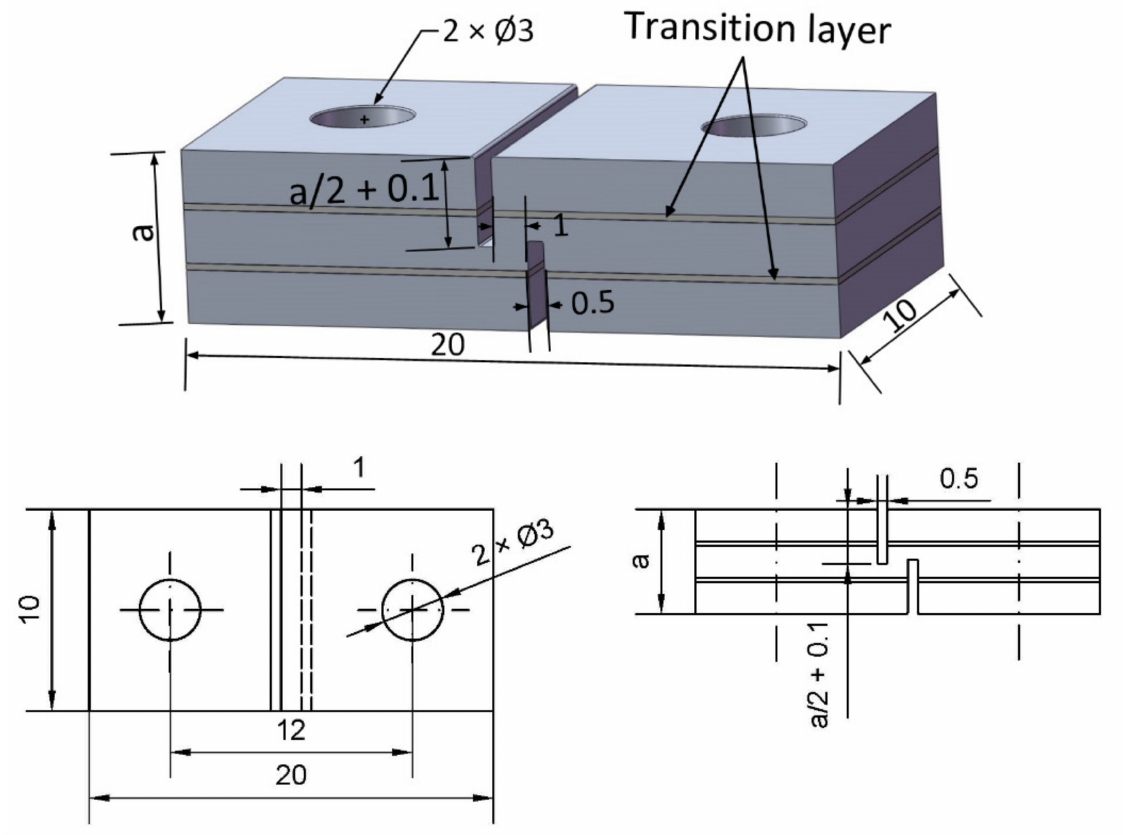
Figure 2. The specimen of the shearing test (units: